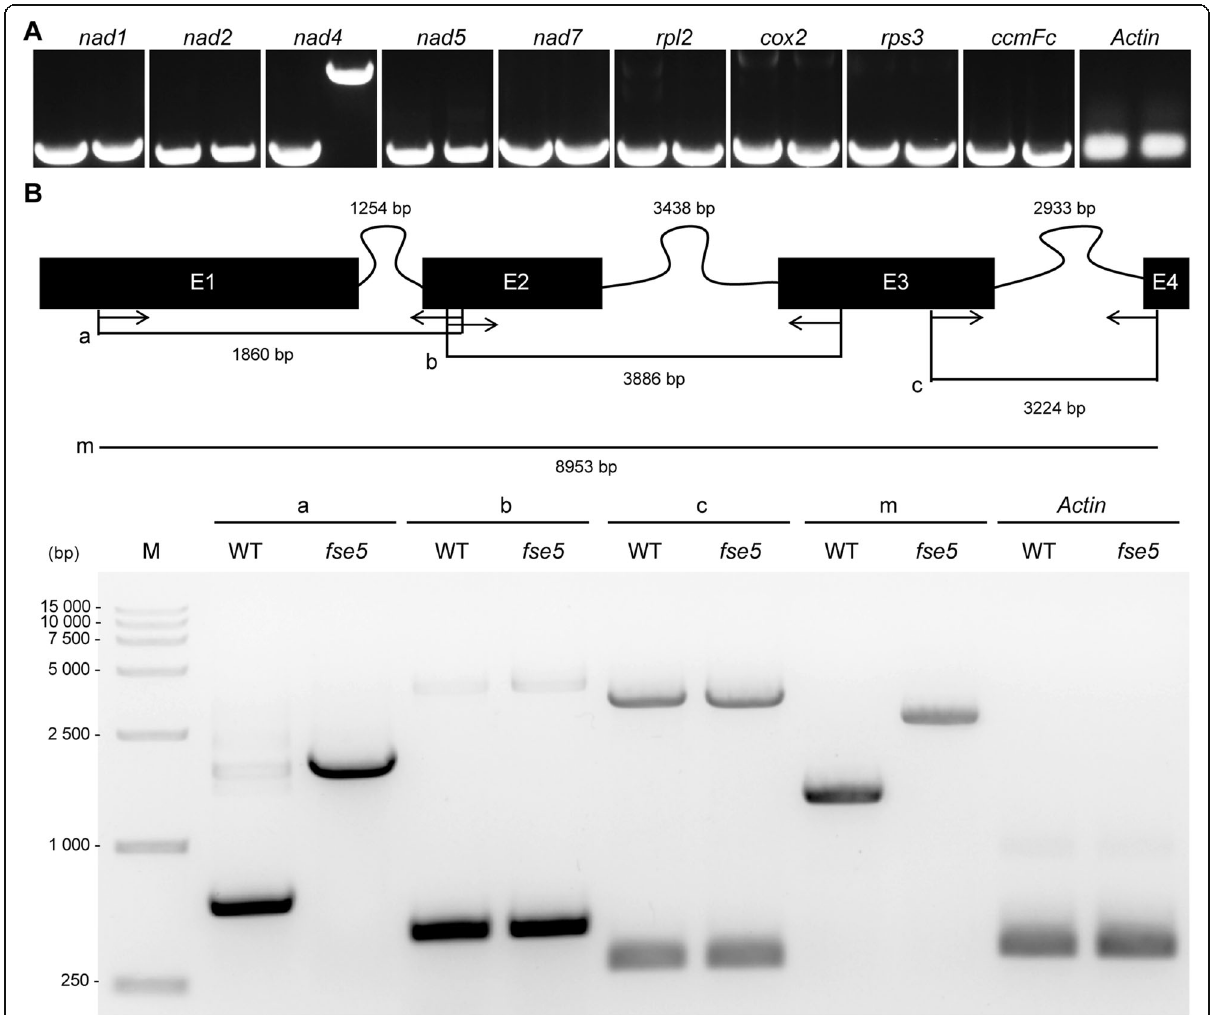
Fig. 6 Splicing of nad4 intron 1 was abolished in the fse5 mutant. Total RNA was extracted from nine-day-old seedlings, and random hexamer primers were used to synthetize first-strand cDNA. a , Transcript analysis of mitochondrial intron-containing genes in the WT (left) and fse5 mutant (right). OsActin1 was used as the internal control. Specific primers were used to amplify 9 transcripts (Wu et al. 2019). b , Schematic of nad4 precursor mRNA and RT-PCR analysis of three introns of nad4 . nad4 precursor mRNA consists of 4 exons (E1-E4) and 3 introns. The black boxes indicate exons, and the curved lines represent introns. a, b, c, and m are fragments amplified by exon-exon flanking primers (Chen et al. 2017). Numbers of nucleic acids included by the introns and fragments are noted. M, DNA